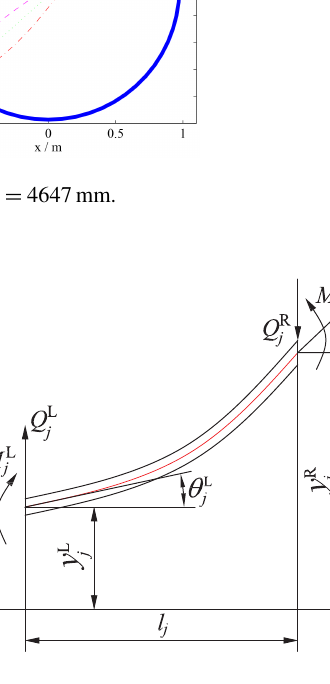
Figure 8. Mechanics analysis of shaft